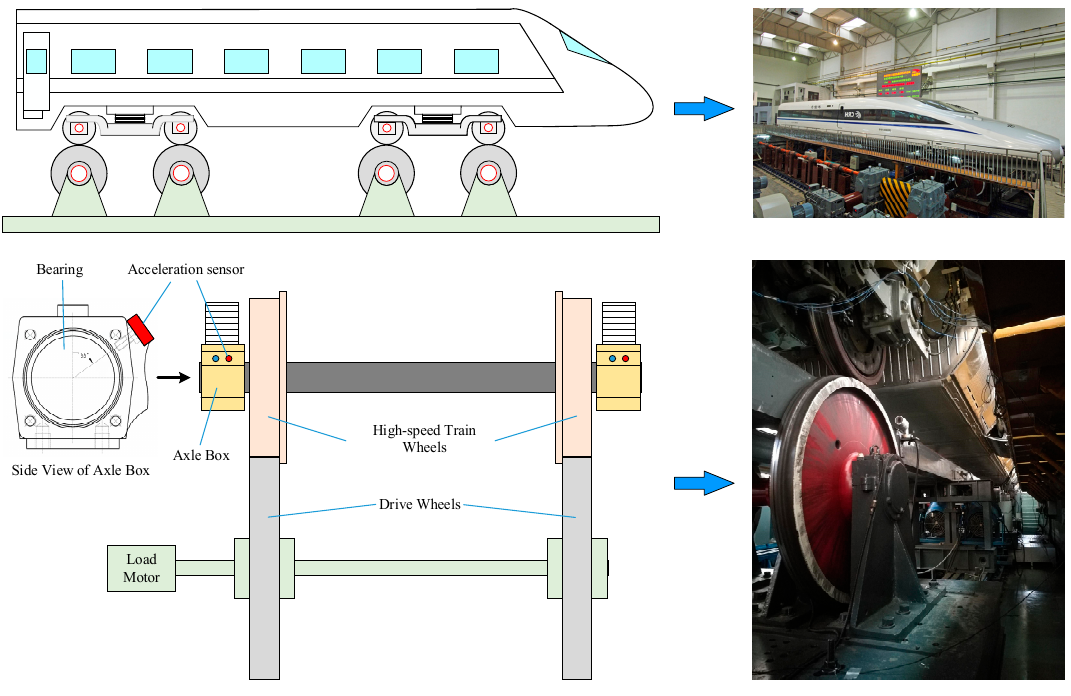
Figure 11. High-speed train rolling test rig.